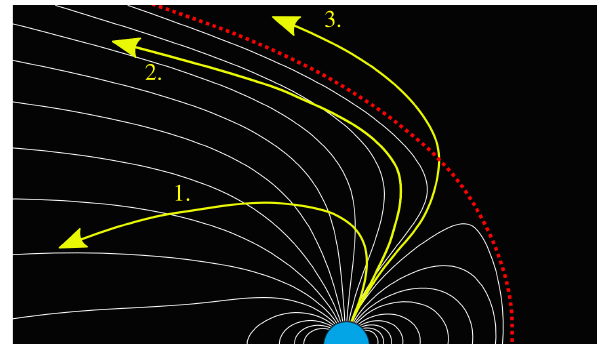
Figure 1. An illustration of possible magnetospheric ion out- flow trajectories: (1) low-energy ion transport to the plasma sheet; (2) high-energy ion flows in the plasma mantle leading to escape downstream in the tail; (3) high-energy ion escape directly from the cusp into the high-latitude dayside magnetosheath. The red dashed line illustrates the